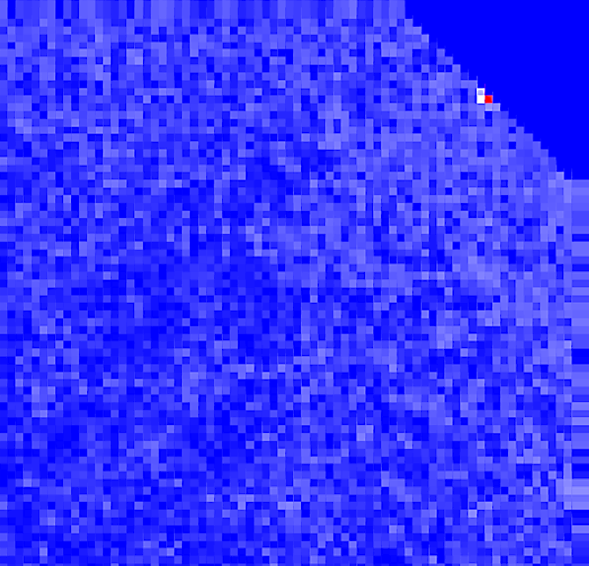
Figure 4. An example surface curvature calculation. Redder regions indicate areas of high curvature. The obstacle region can be seen in the upper right of the image.